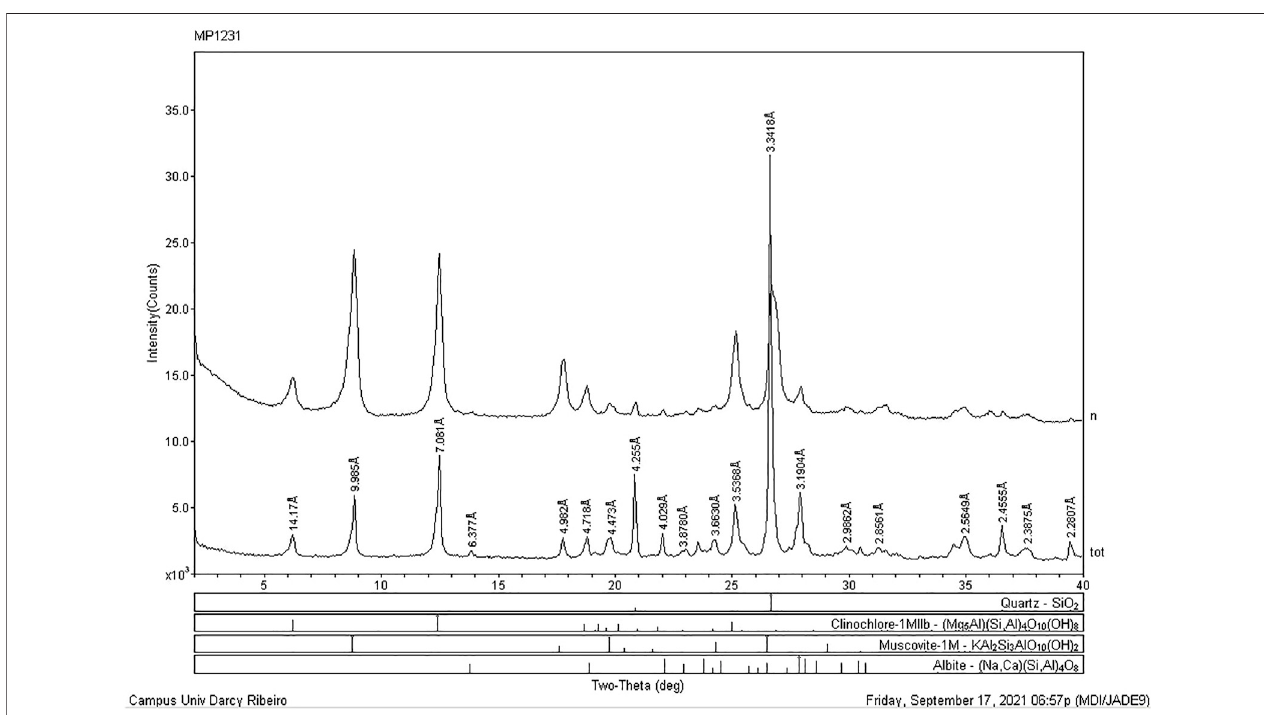
FIGURE8| DiffractogramsofsampleMP1231fromBambuíGroup,MunicipalityofBuritis,MinasGeraisState,Brazil.Wholerock(tot)andclayfraction(n);notethe variation in re fl ection intensities.